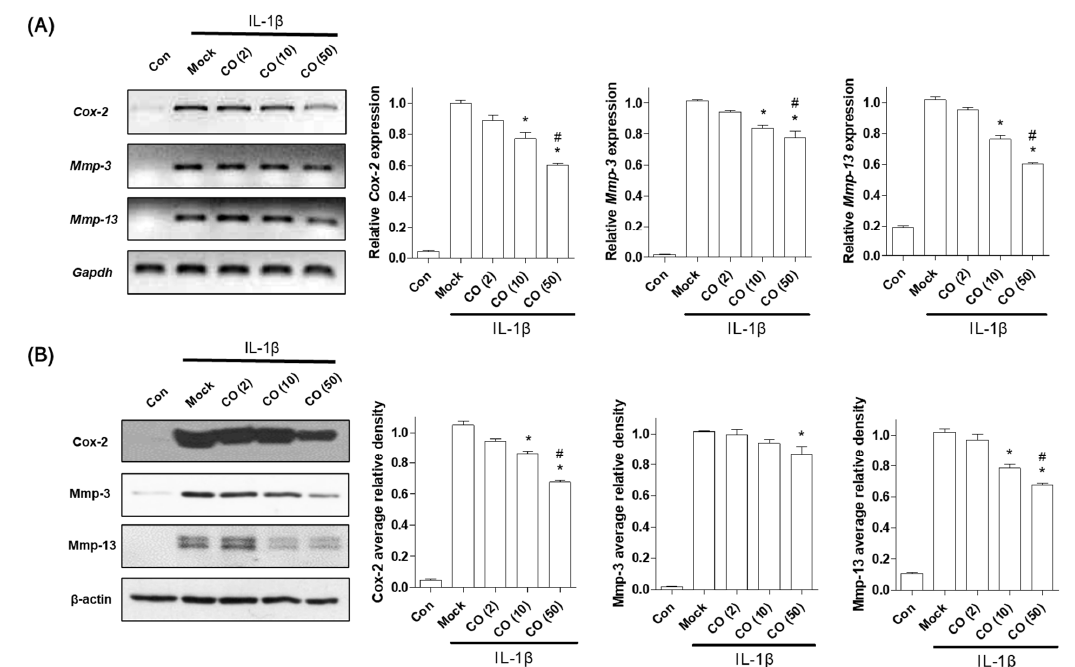
Figure 1. Inhibitory effect of Cornus officinalis (CO) extract on chondrocyte inflammation. Mouse primary chondrocytes were exposed to interleukin-1 beta (IL-1 β ) and treated with CO extract (2, 10, and 50 μ g/mL) for 48 h. ( A ) mRNA expression levels of mouse COX-2, MMP-3, and MMP-13 were assessed by reverse-transcriptase polymerase chain reaction (RT-PCR, left) and quantitative RT-PCR (qRT-PCR, right). Gapdh was used as an internal control. ( B ) Cell lysates were subjected to Western blot analysis to evaluate mouse COX-2, MMP-3, and MMP-13 (left). β -actin was used as an internal control. The representative image is presented in the left panel, and the densities of three independent experiments are quantified and illustrated in the right panel. The bar graph was analyzed using one-way ANOVA (Tukey’s honest significant difference post-hoc test, analysis of variance). * p < 0.05 vs. Mock, # p < 0.05 vs. CO (2). Con = control; Mock = non-treated; CO = CO extract.